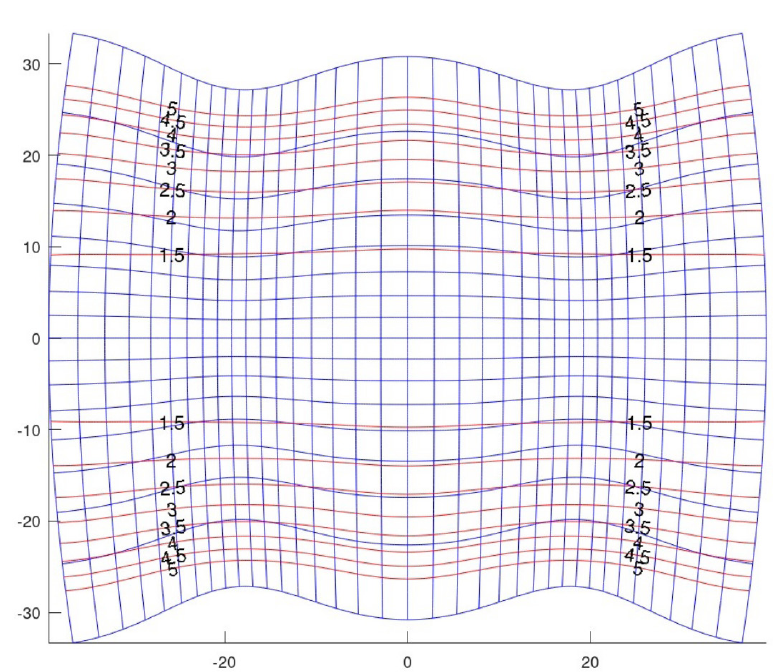
z of the function 4 arcsin 4